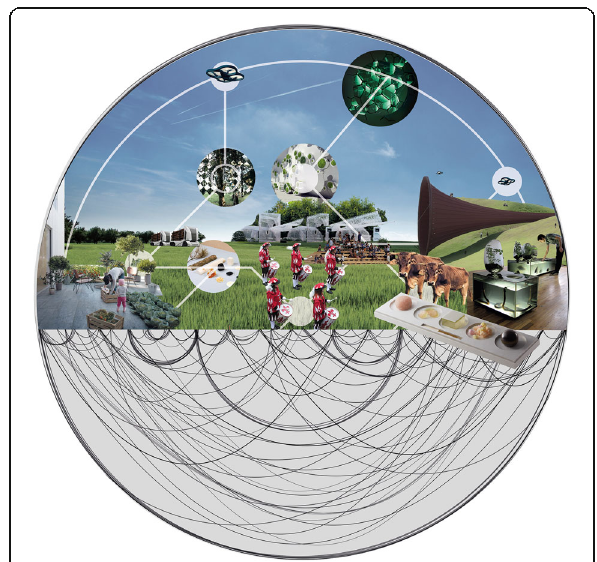
Fig. 3 The digitally rooted region © Fraunhofer CeRRI